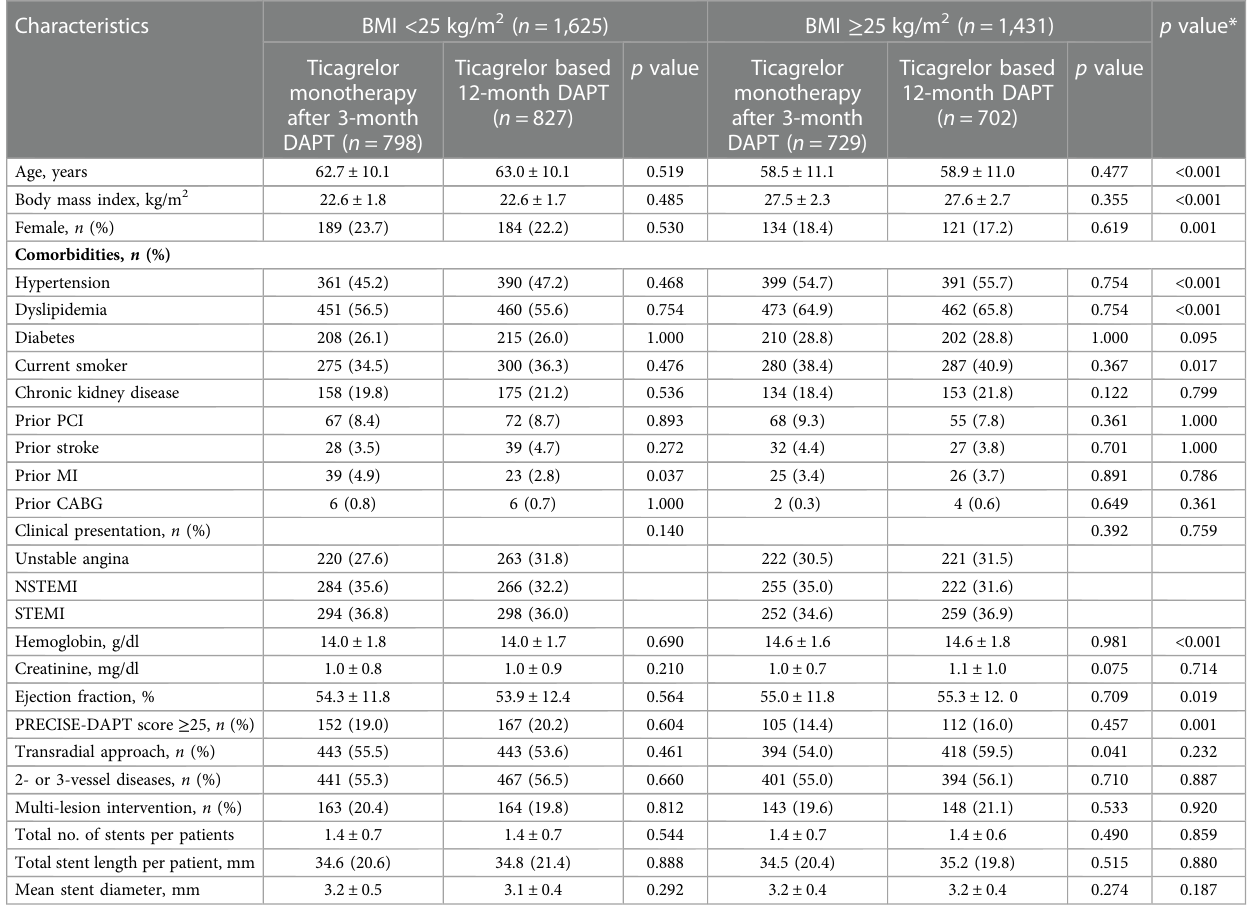
TABLE 1 Baseline characteristics according to the pre-speci fi ed BMI subgroups and antiplatelet strategy. Characteristics